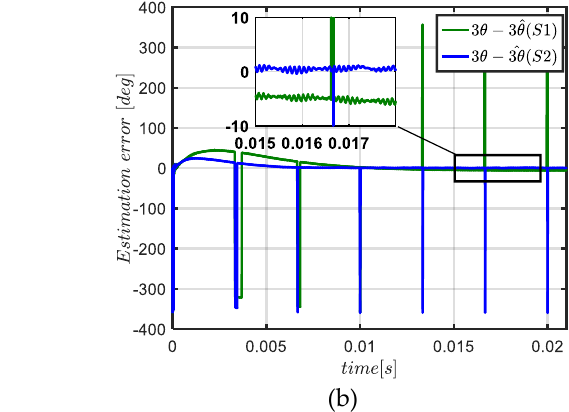
Table 4. Resulting position error (electrical angle) from strategies ( S1 ) and ( S2 ) .